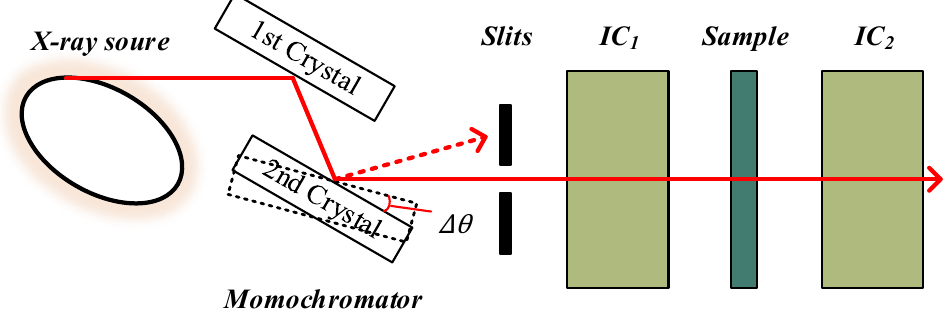
Figure 1. The structure of the